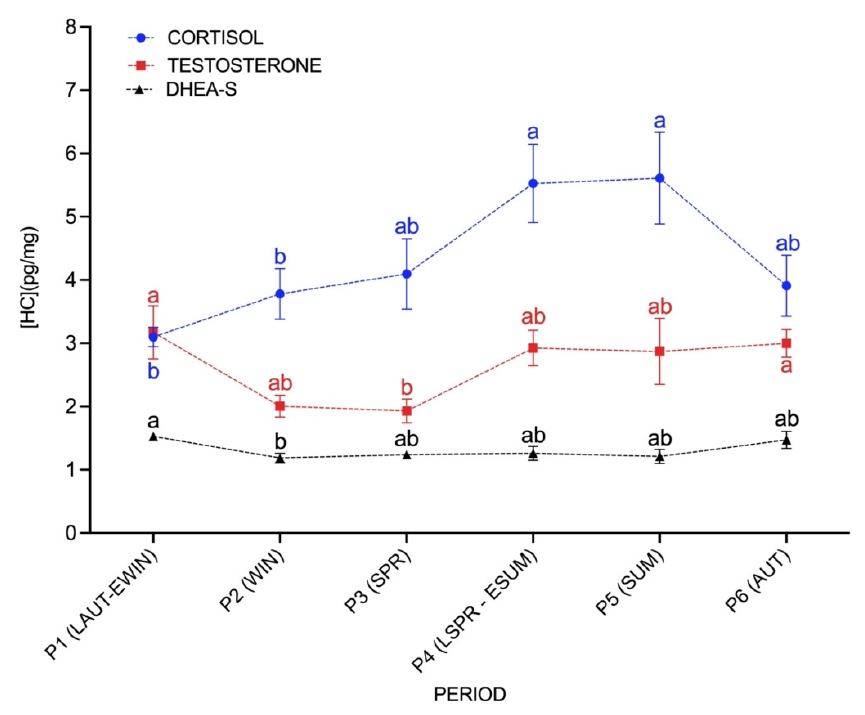
Figure 1. Hair C ( 〇 blue), T ( red) and DHEA-S ( ∆ black) concentrations during the studied period (P1; late autumn-early winter, P2; winter, P3; spring, P4; late spring-early summer, P5; summer, P6; autumn). Data are graphically presented as mean ± SEM. HC—hormone concentrations. Different letters represent significant differences between periods ( p < 0.05).